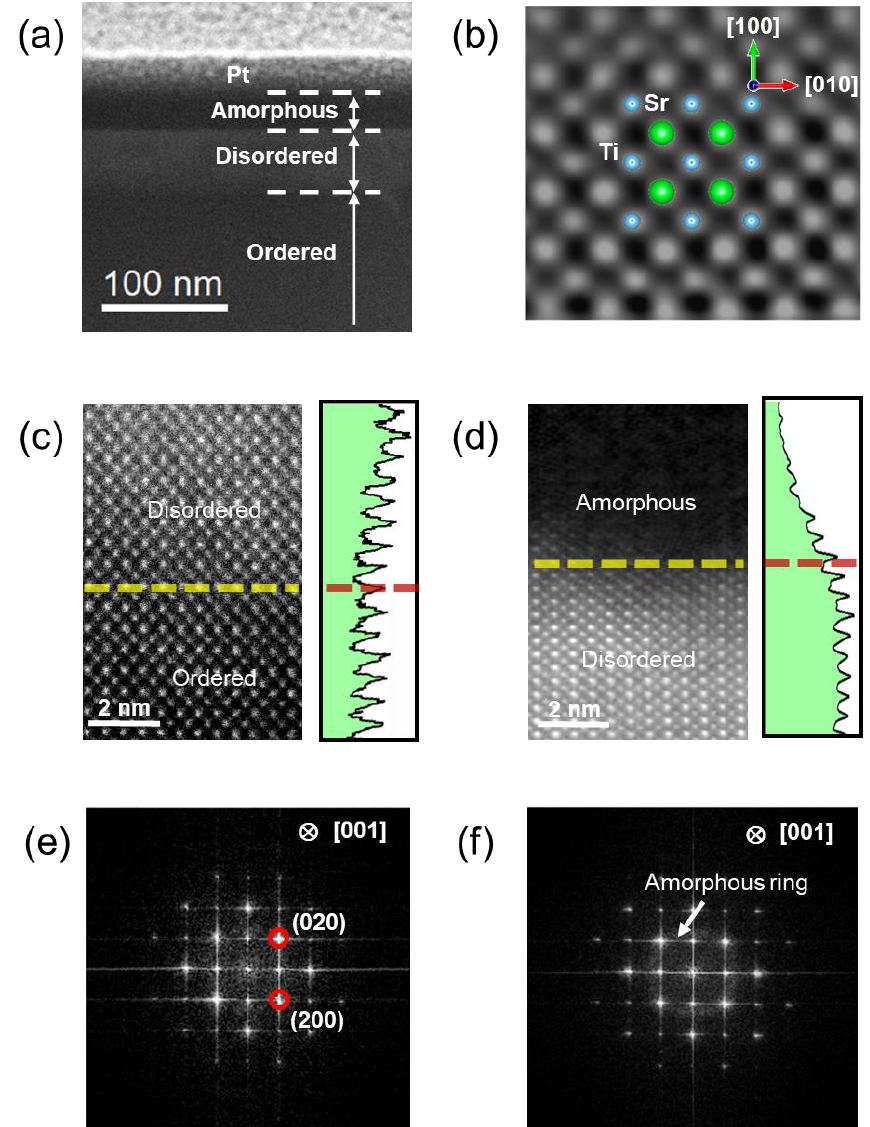
Figure 2. ( a ) The cross-sectional STEM image showing amorphous, disordered, and ordered regions. ( b ) Schematic model of SrTiO 3 in [001] zone axis superimposed over the ordered lattice structure. ( c ) ADF image depicting disordered and ordered region, the plot adjacent illustrates an intensity profile. Similarly, ( d ) shows an ADF image depicting disordered and amorphous regions, the plot adjacent illustrates the intensity profile. ( e , f ) Depicts fast Fourier transforms from ordered/disordered region and disordered/amorphous region, respectively.